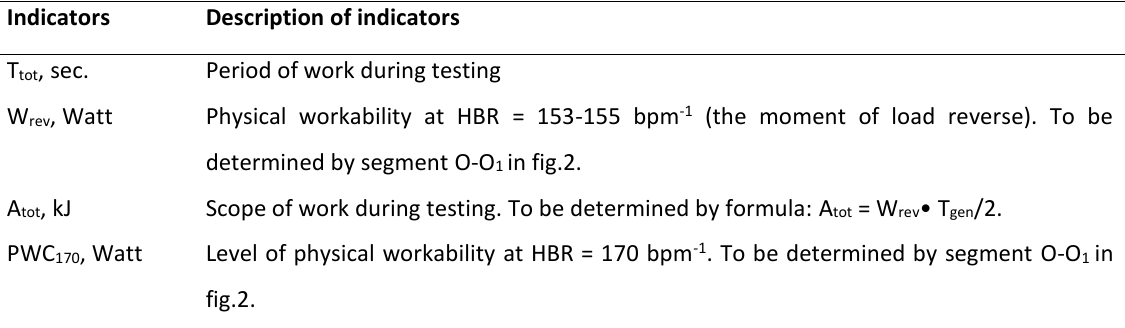
Table 1. Indicators of physical workability Indicators Description of